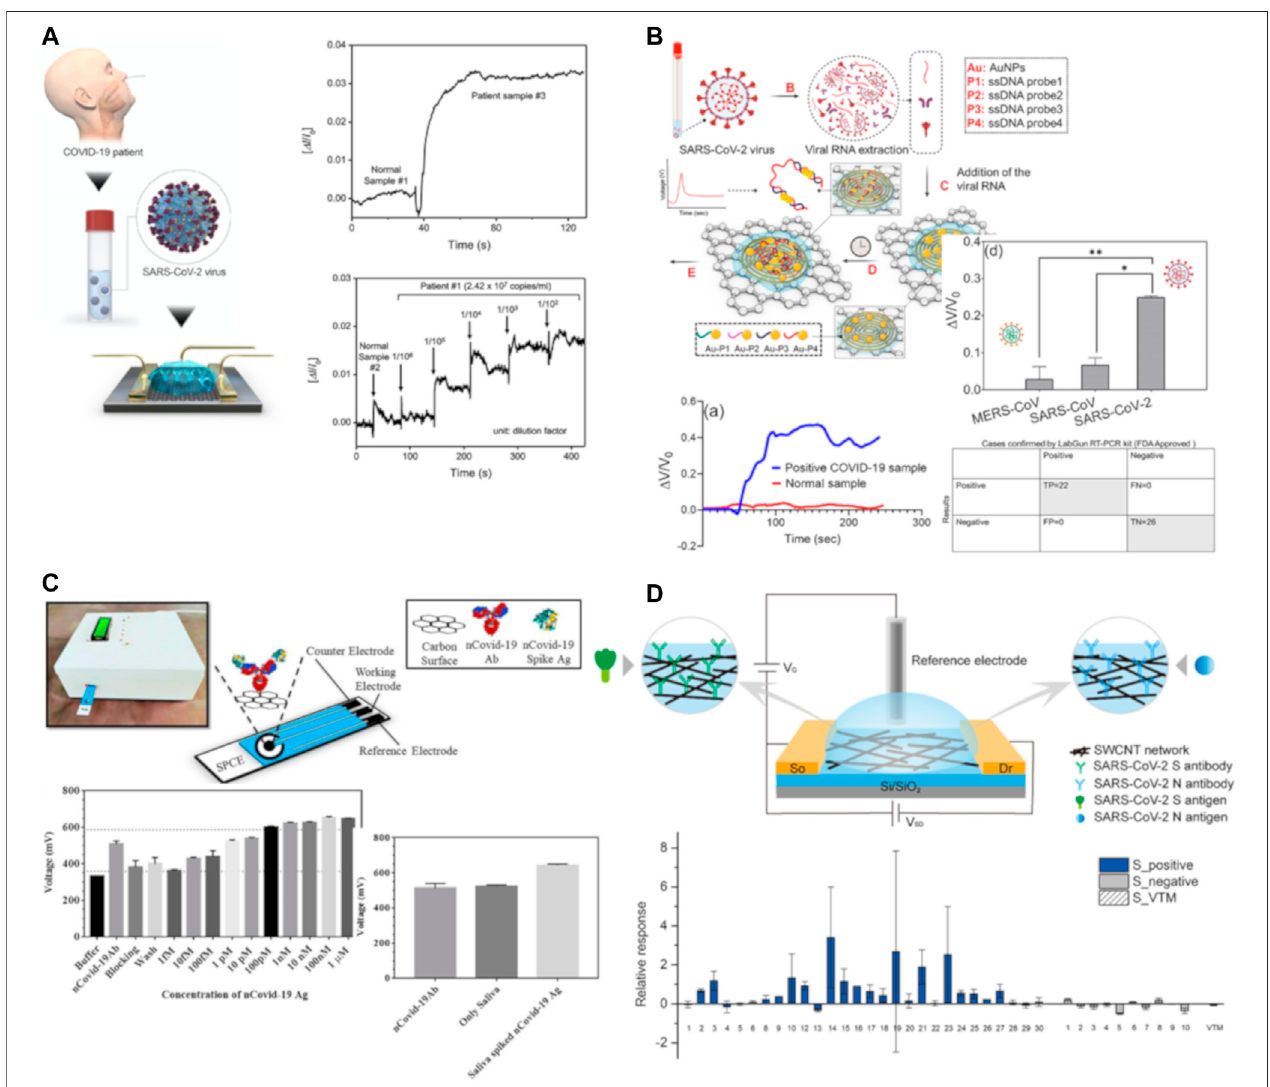
FIGURE 4 | Representative examples of electrochemical nanosensors for COVID-19 detection. (A) Graphene-based fi eld effect transistor (FET), conjugated with an antibody against the spike protein of SARS-CoV-2. Plots show response signal from normal v. COVID-19 positive patient, and dose-dependent response curve. Credit: Reprinted (adapted) from (Seo et al., 2020), part of the ACS COVID-19 subset. Copyright © 2020, American Chemical Society. (B) Paper-based electrochemical sensor based on Au nanoparticles capped with antisense oligonucleotides targeting the N-gene of SARS-CoV-2, on a graphene substrate. Protocol shows work fl ow from human sample to RNA extraction, 5 min incubation and sensor readout. Plots show sensor response difference between COVID-19 positive and healthy samples, the ability to distinguish between SARS-CoV-2 and related coronaviruses (MERS-CoV or SARS-CoV), and confusion matrix of the classi fi cationresultsofthesensoron n (cid:2) 48clinicalsamples,comparedtothestandardRT-PCRassayresults.Credit:Reprinted(adapted)from(Alafeefetal.,2020), part of the ACS COVID-19 subset. Copyright © 2020, American Chemical Society. (C) eCovSens device, based on a screen printed carbon electrode with an nCovid-19 antibody immobilized on a graphene surface. Plots show sensor response to the nCovid-19 antigen at different concentrations (1 fM – 1 µM), and saliva- spiked samples. Reprinted (adapted) with permission from (Mahari et al., 2020). (D) Liquid-gated single-walled carbon-nanotube FET for detection of the spike proteinornucleocapsid proteinofSARS-CoV-2virus.Responseofspikeantibody-functionalized FETsensortoclinicalsamples,containingbothCOVID-19positive and negative cases, and blank viral transport medium (VTM). Sensitivity of detection was 82% (23 out of 28 COVID-19 positive detected), compared to the standard nucleic acid ampli fi cation test results. Credit: Reprinted (adapted) from (Shao et al., 2021), part of the ACS COVID-19 subset. Copyright © 2021, American Chemical Society.